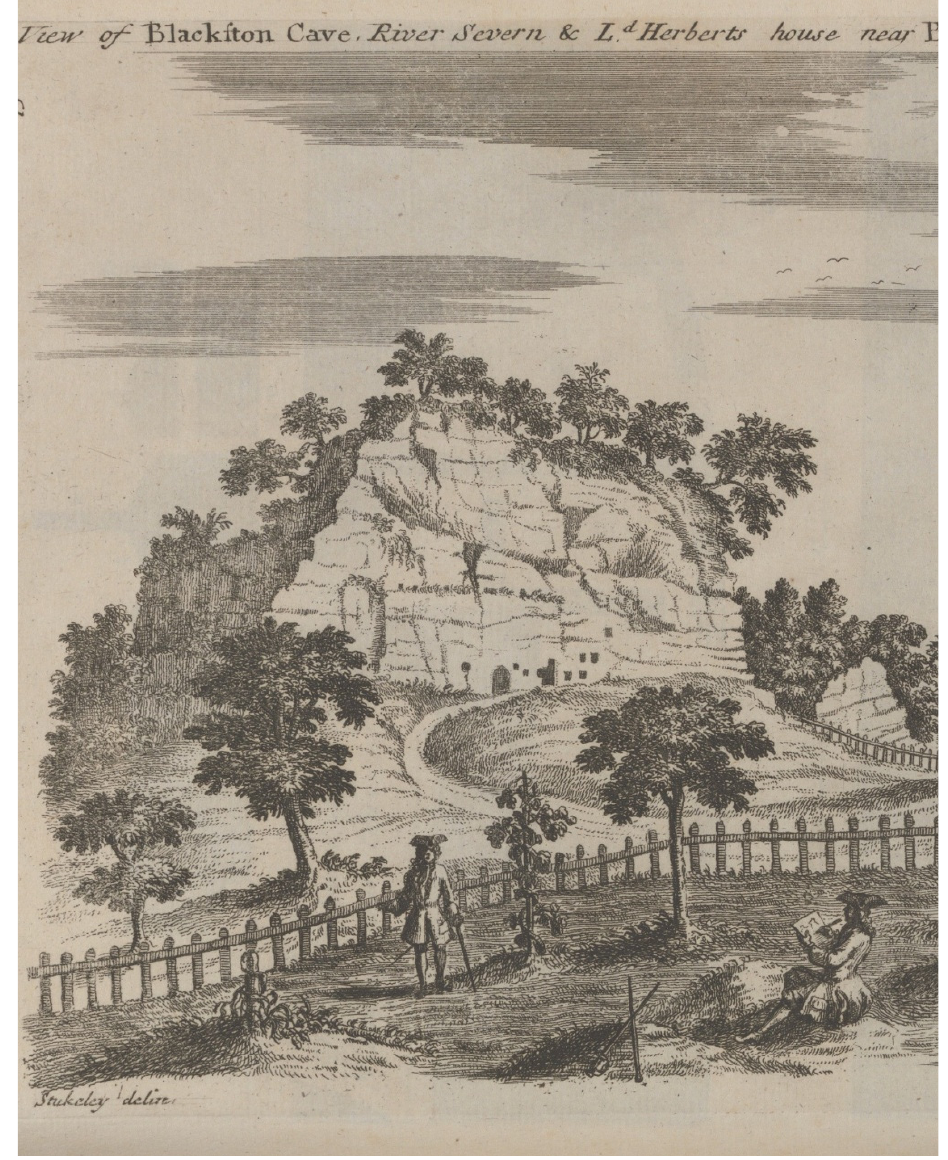
Figure 1. (Stukeley and Kirkall 1721) Stukeley, William, and Elisha Kirkall, artist and engraver. 1721. View of Blackston Cave, River Severn & Ld Herberts house near Bewdley Sep 23 1721. In the Series Itinerium Curiosum. Bewdley: Worcestershire. Available online: http://www.rareoldprints.com/p/ 722 (accessed on 28 December 2021). Copyright Status: Public Domain.